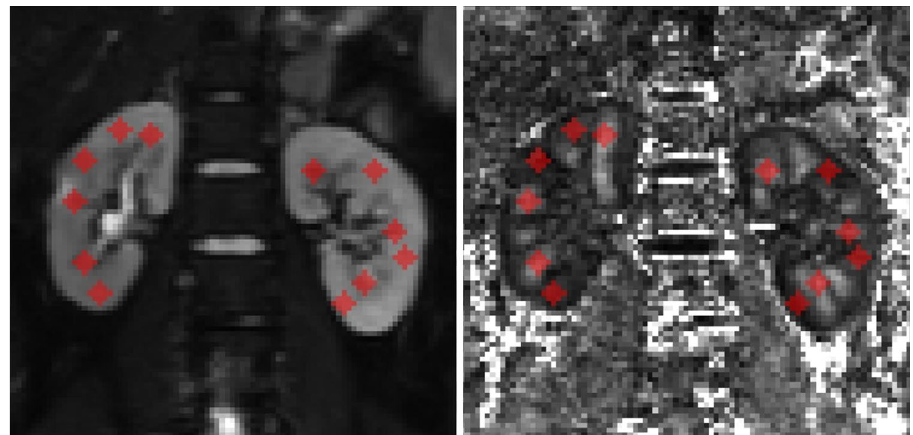
Figure 1. Kidneys regions of interest (ROIs) in a Bardet–Biedl syndrome patient. Baseline, b = 0 s/mm 2 (left) and fractional anisotropy (right) of a BBS subject included in the present study overlaid with ROIs (red circles). The ROIs were positioned in the upper, middle and inferior kidney poles in both the medullary and cortical